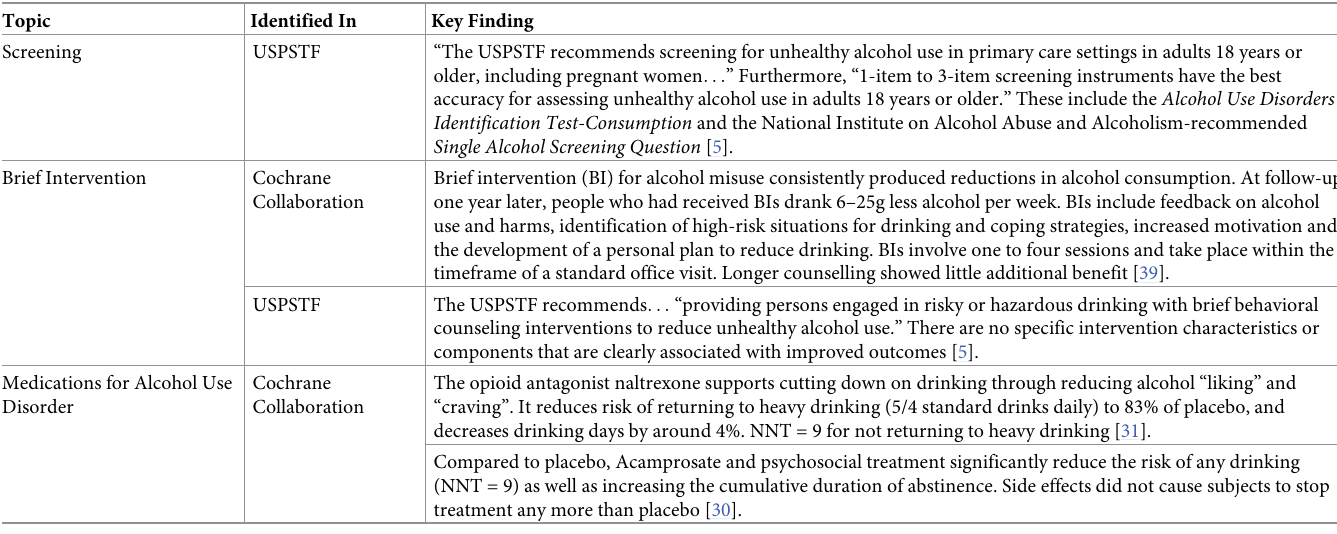
Table 2. Evidence-based interventions recommended for addressing unhealthy alcohol use in primary